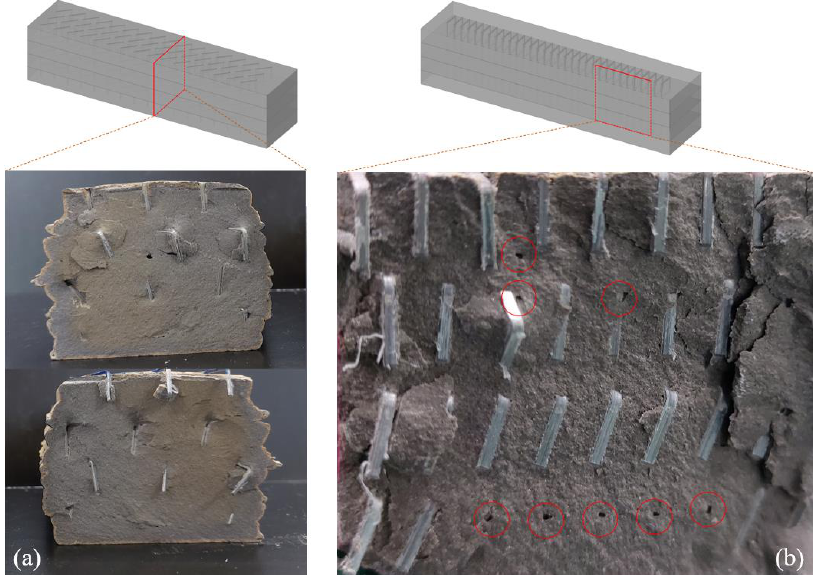
Figure 11. Failure of the IR- samples: ( a ) photograph of the broken IR-3 and its location, and ( b ) photograph of the broken IR-7 and its location with gaps in red circles.